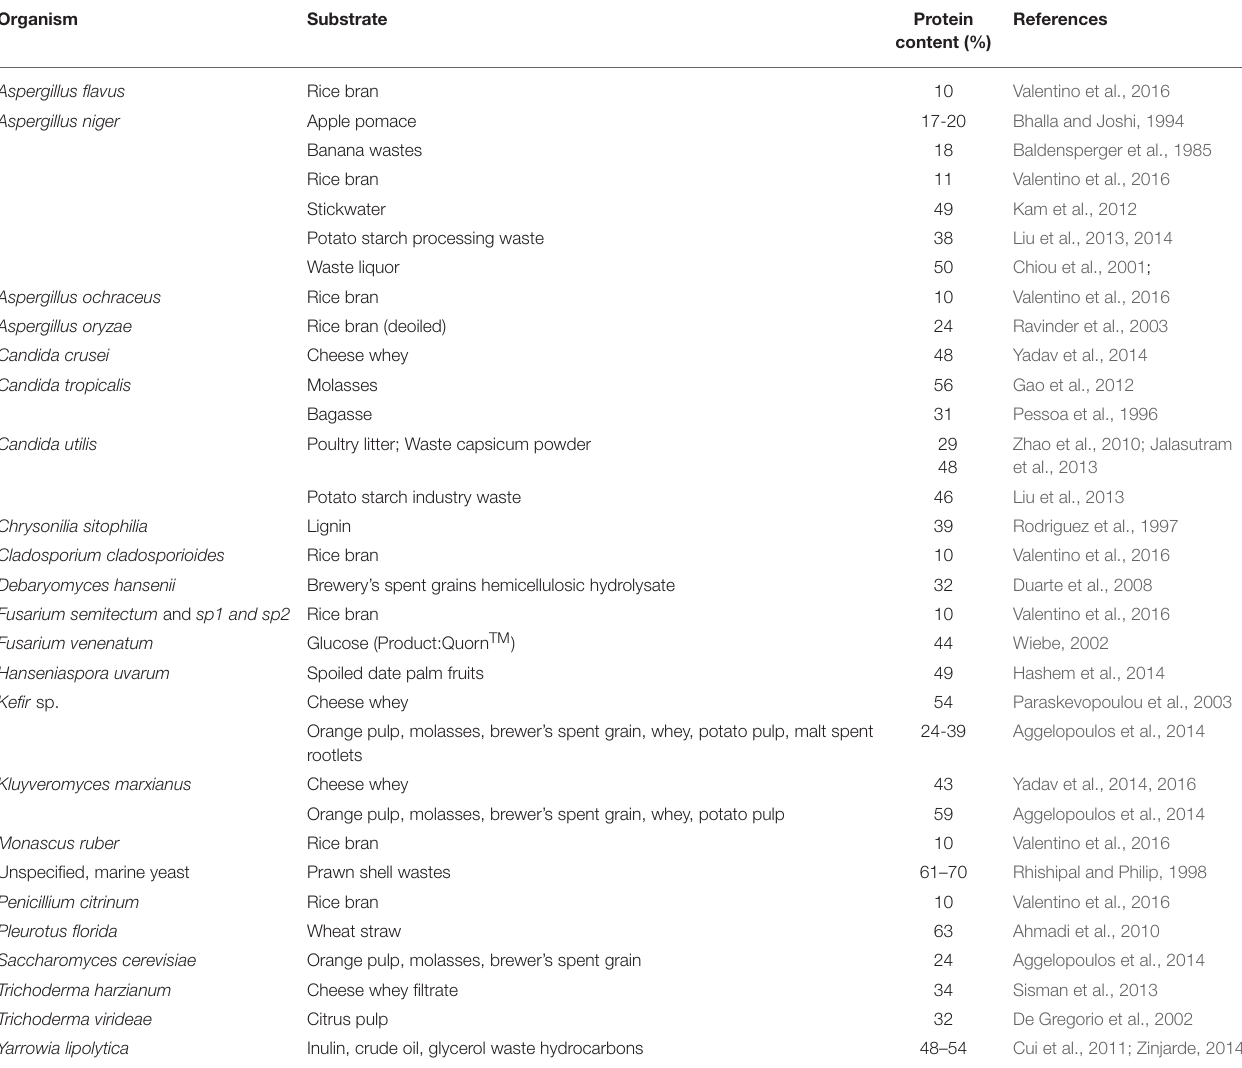
TABLE 2 | Recent reports of fungal protein content produced from specific substrates for species investigated as potential sources of